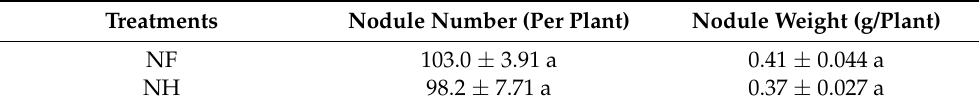
Table 1. Changes in nodules number and dry weight of dual-root soybeans after nitrogen